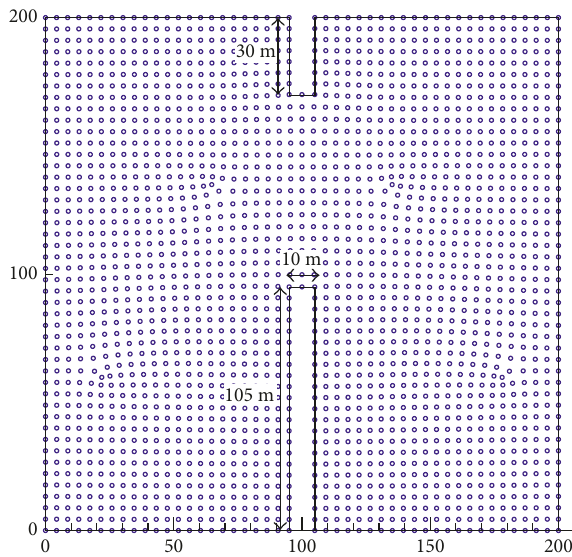
Figure 3: The computational domain and RBF collocation points of the 2D dam break problem.